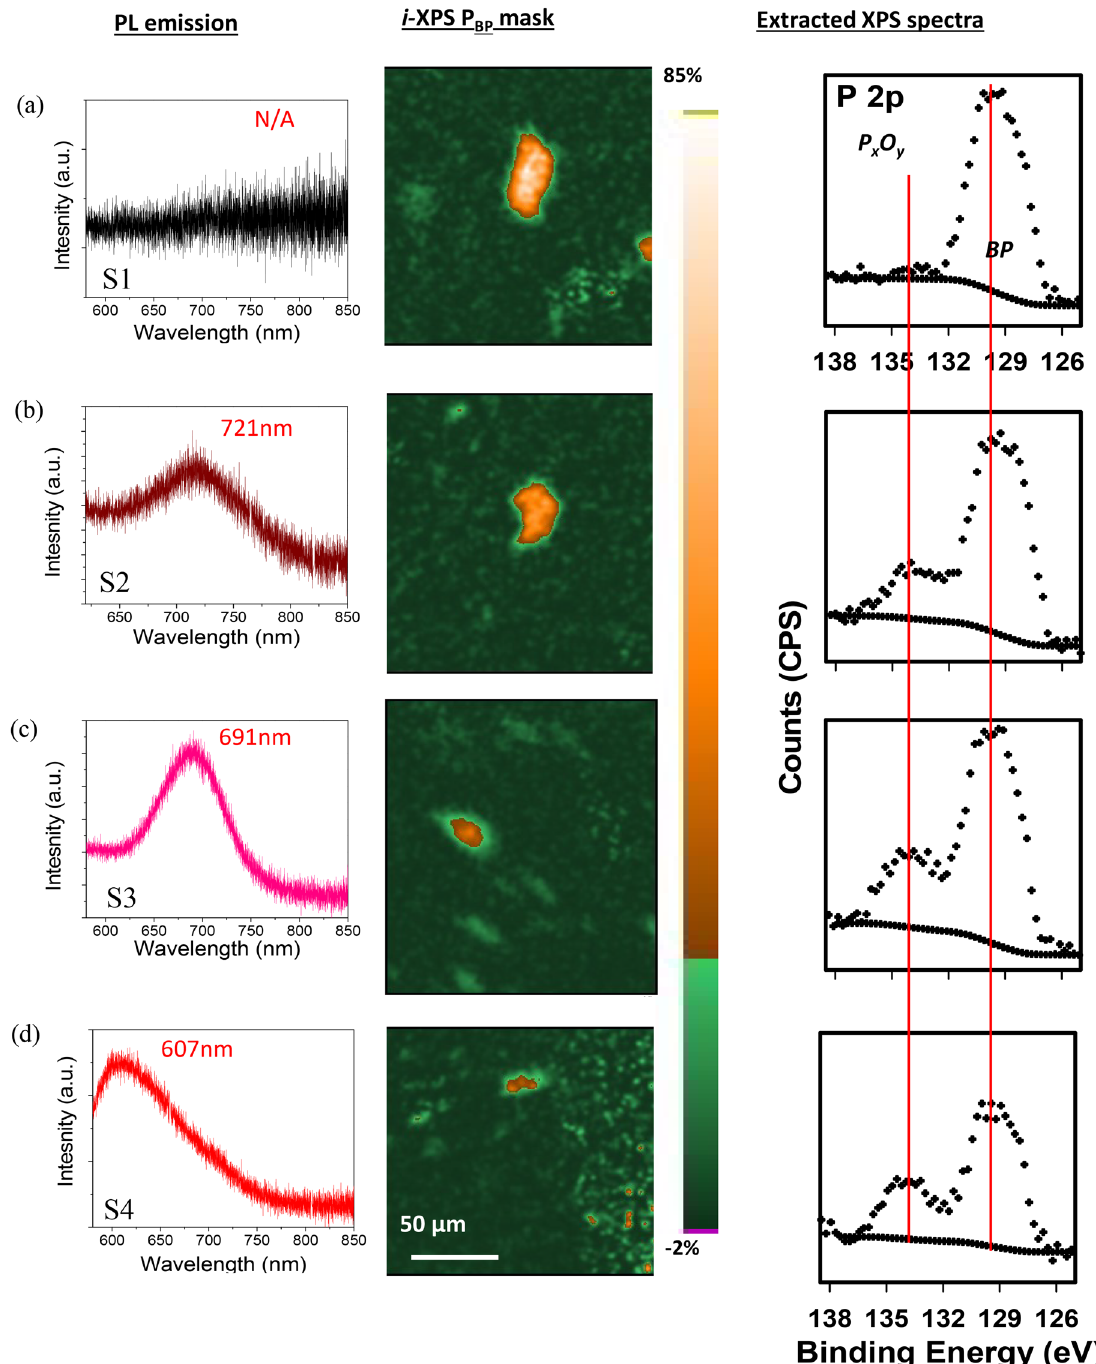
Figure 5: Imaging X-ray photoelectron spectroscopy ( i -XPS) measurements for (a) a nontreated black phosphorus nanosheet and (b – d) several treated black phosphorus nanosheets with light emission at 721, 691, and 607 nm,